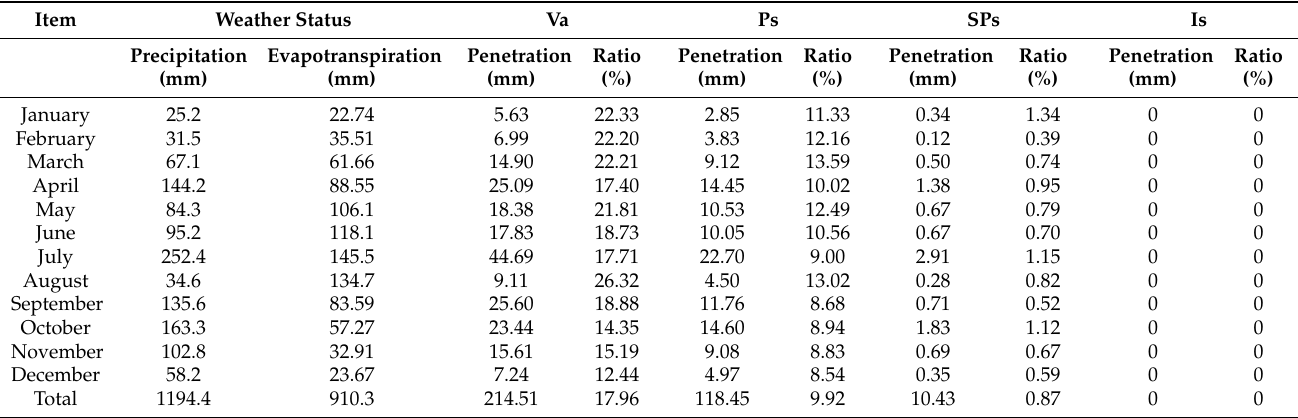
Table 2. Analysis of monthly groundwater